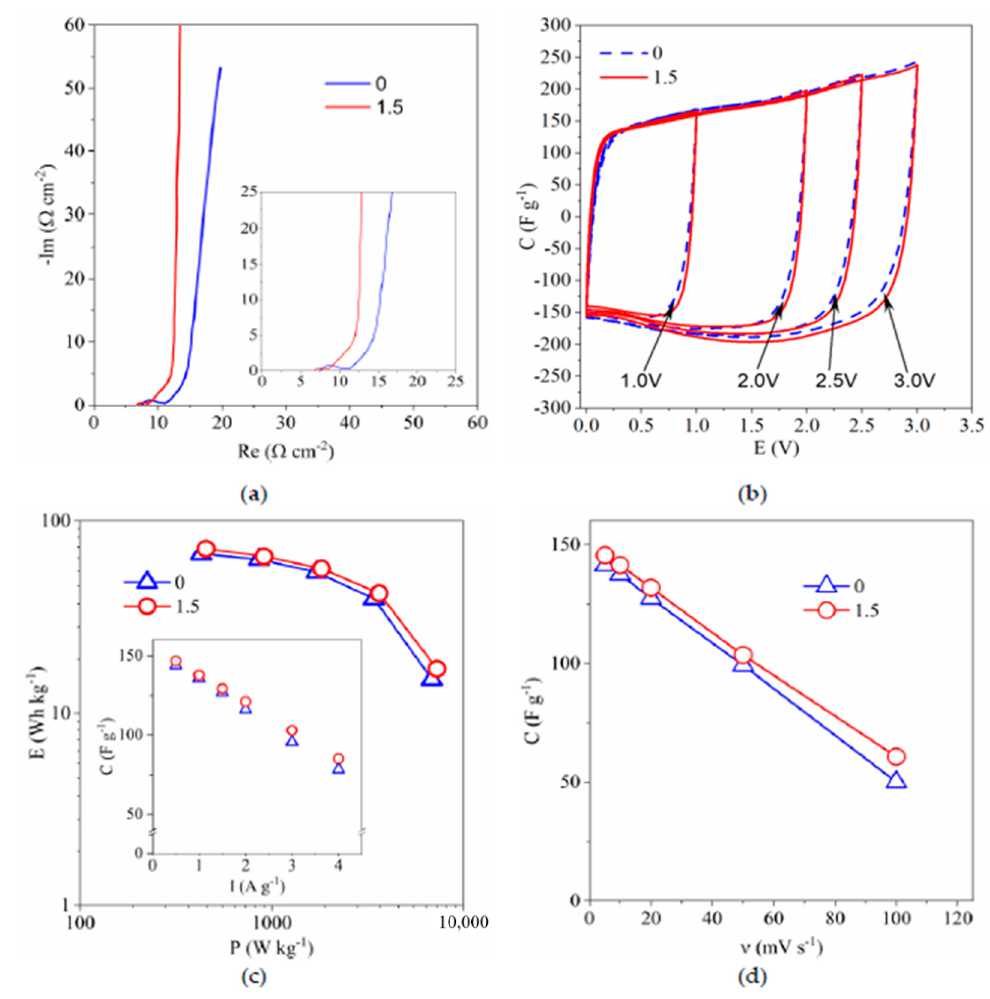
Figure 10. ( a ) Nyquist plot, ( b ) Cyclic voltammograms up to various values of maximum potential. Scan rate 5 mV · s − 1 , ( c ) Ragone plot and discharge capacitance vs current (inset) of the ECs, ( d ) discharge capacitance vs scan rate of AC/AC capacitors with applied ionogels. Capacitance, current, energy, and power expressed per AC mass in one electrode. Numbers indicate the 8M-POSS content in the compositions expressed in wt.%.